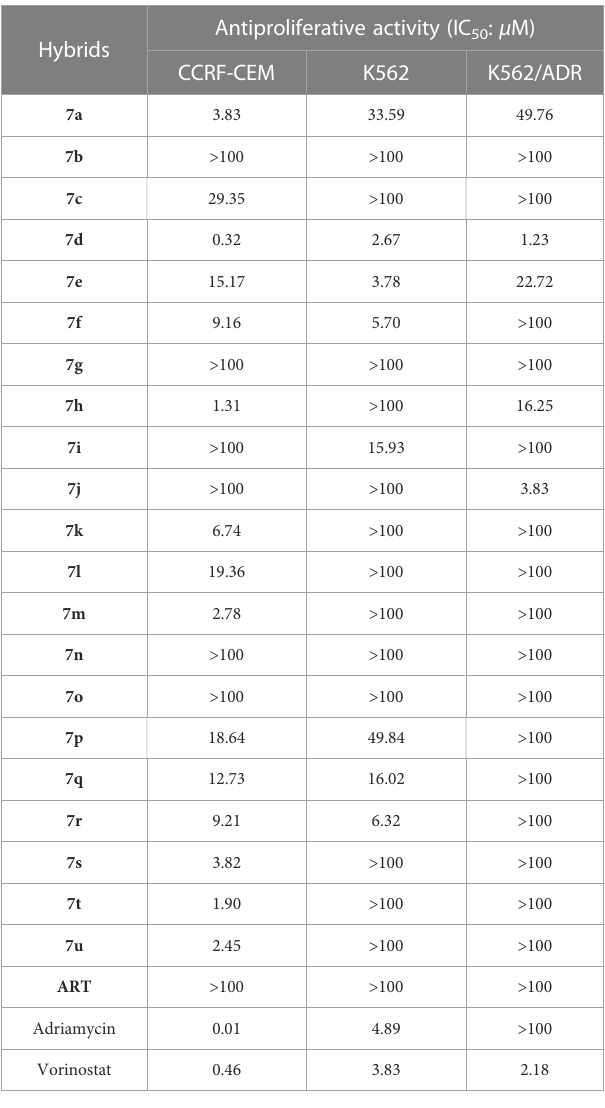
TABLE 2 The antiproliferative activity of ART-isatin hybrids 7a-u. TABLE 1 The structures and yields of ester tethered ART-isatin